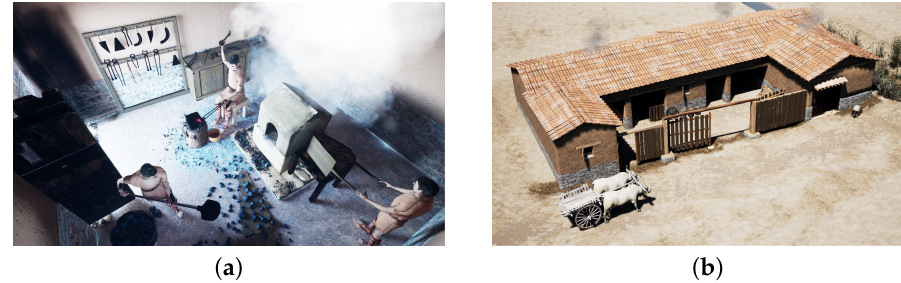
Figure 12. Frames of the video from the permanent exhibition in the Montebelluna civic Museum with details of the Representation Model (RM): interior of room G ( a ) and externals of the craft building ( b